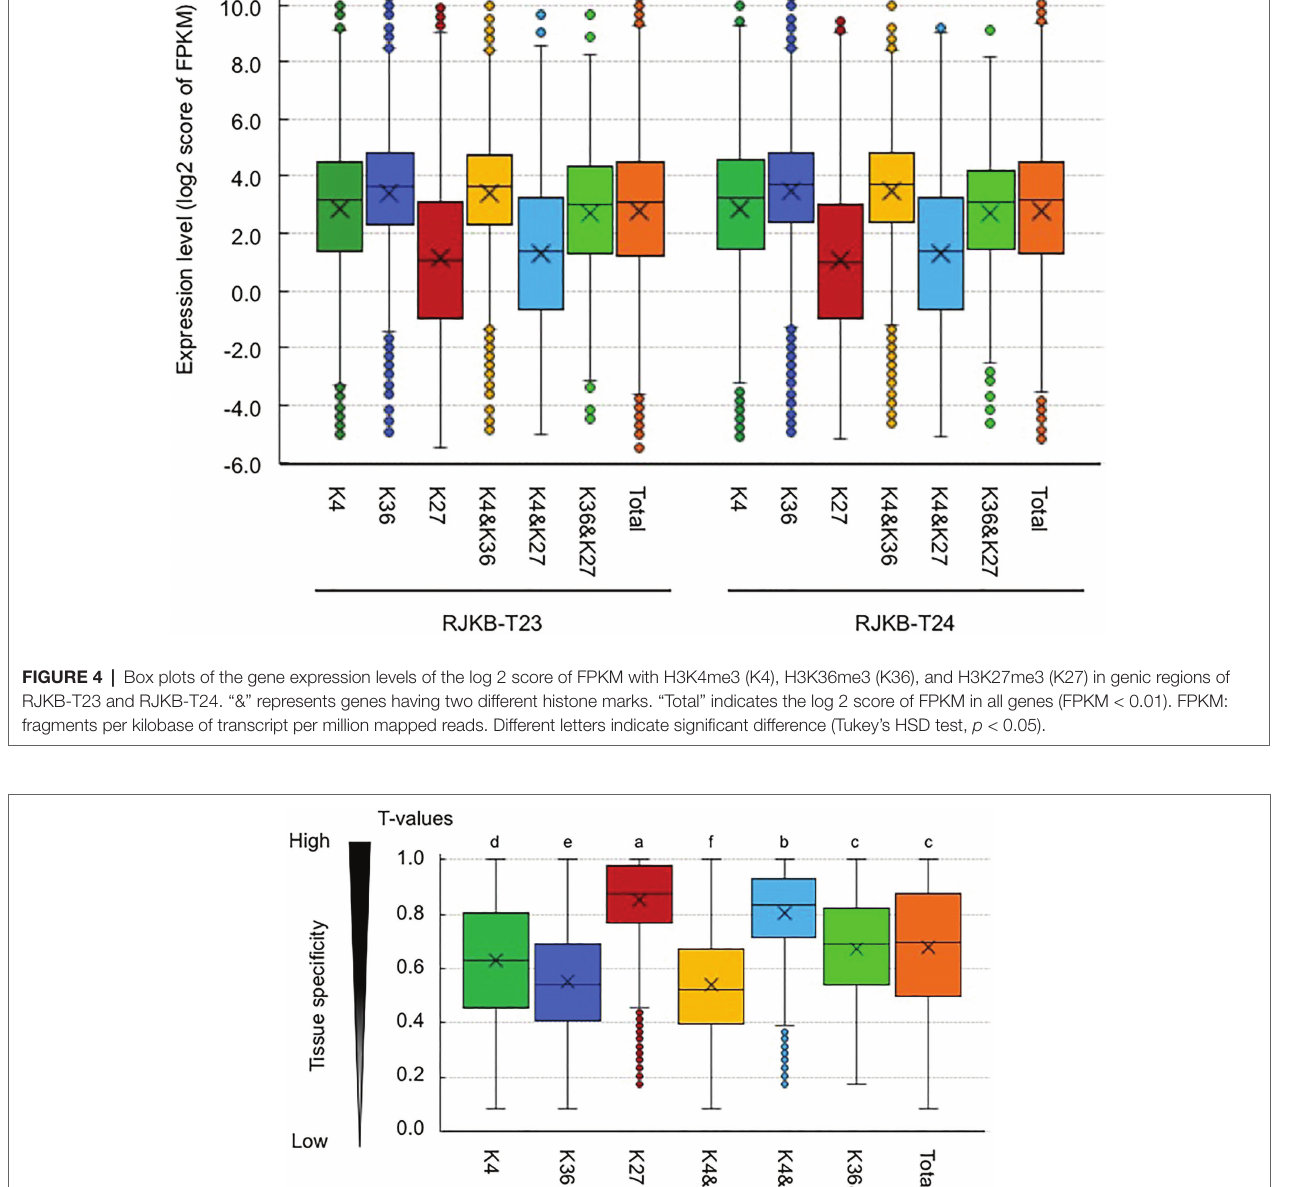
( Supplementary Figure S14 ), while the average T -values of genes with H3K36me3 tended to be lower than those without